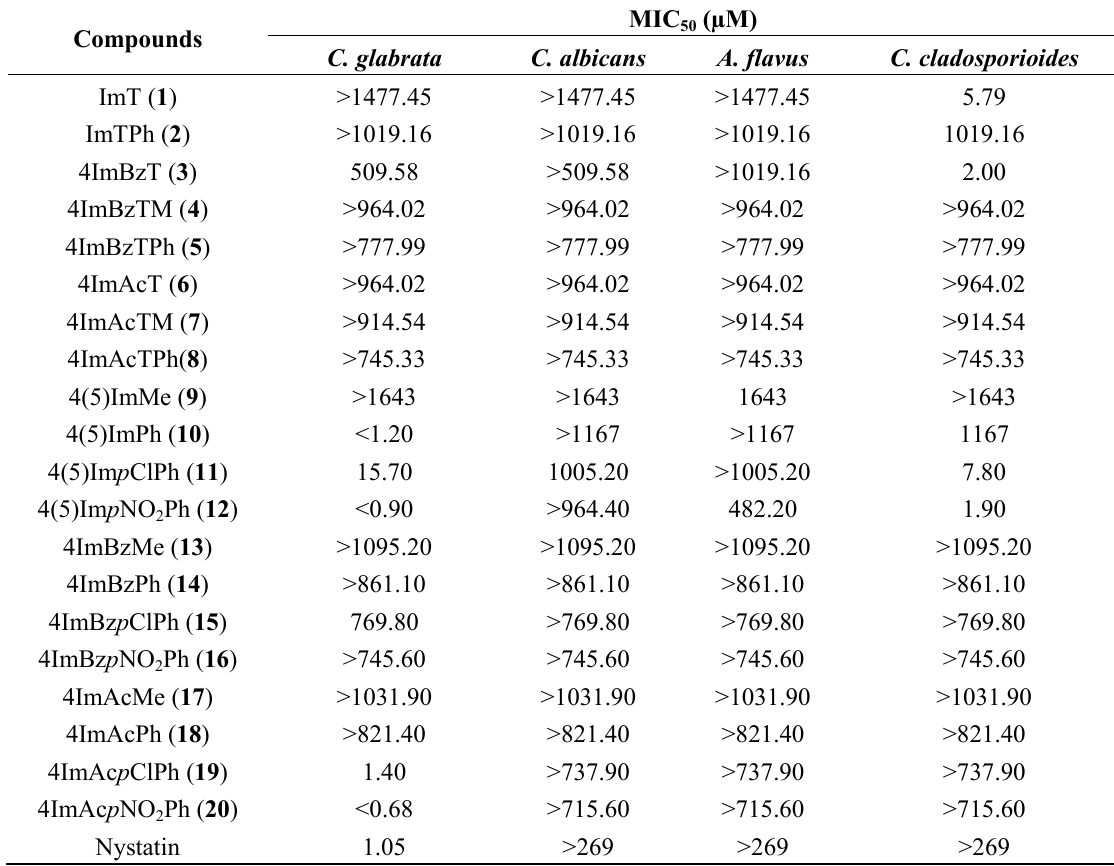
Table 3. MIC of imidazole-derived thiosemicarbazones and hydrazones against 50 phytopathogenic and human pathogenic fungi.